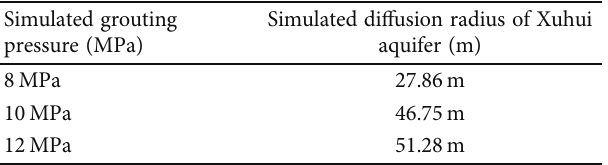
Table 1: Numerical simulation results of slurry di ff usion range.